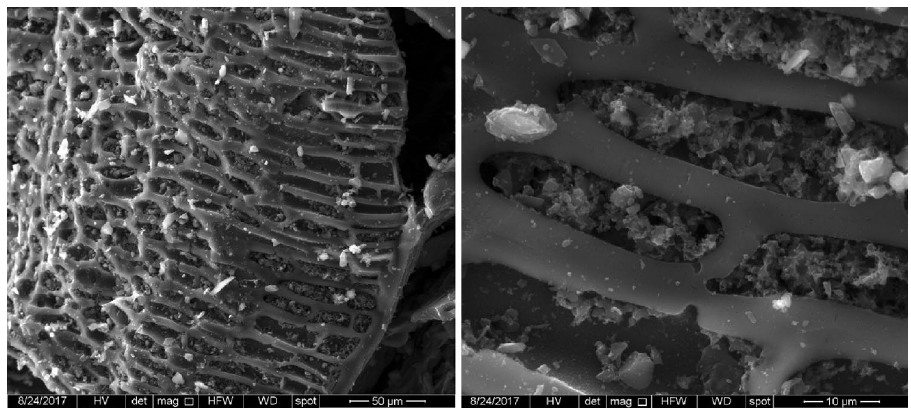
Fig. 1 SEM image of DZCO2 activated chemically with ZnCl 2 and pyrolyzed at 800 °C, then physically by CO